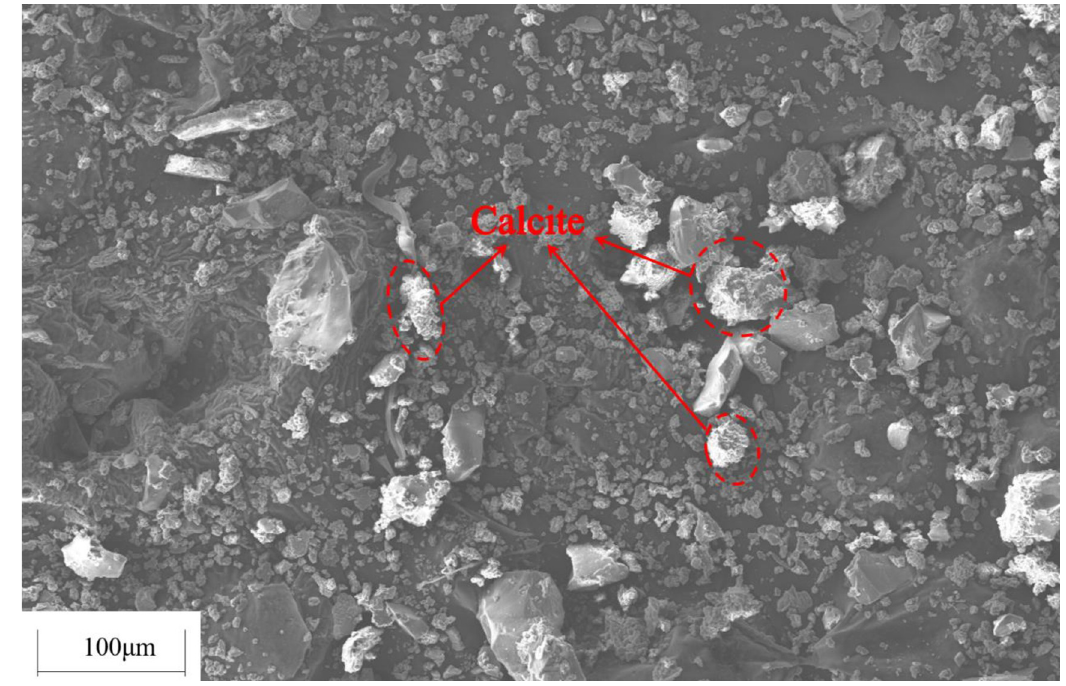
Fig 15. SEM image of cemented tailings